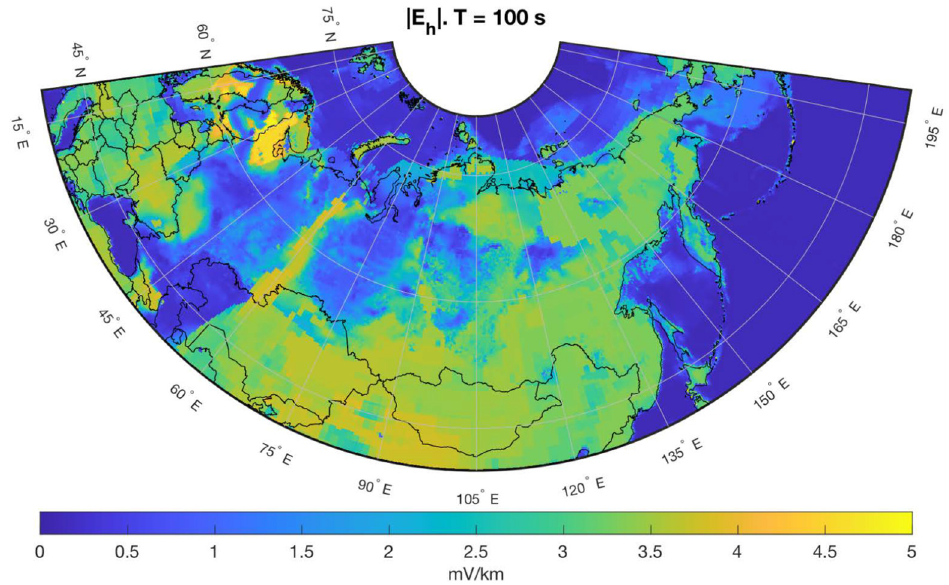
Figure 10. Map of the horizontal geoelectric field magnitude | E H |, excited by uniform magnetic field variations with period T = 100 s and magnitude 1 nT.